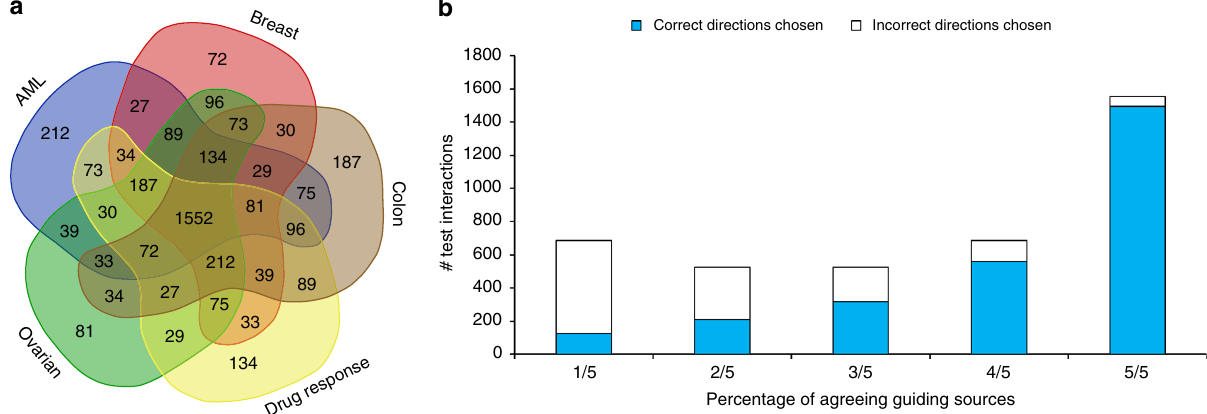
Fig. 4 Concurrence of orientations according to different sources of cause-effect information. a Depicted are the agreement of directions assigned to the test edges when independently orienting the network using (i) drug targets to differentially expressed genes, or (ii) genetic perturbations to differentially expressed genes across different cancer patients (AML, breast, colon and ovarian cancer). b The higher the agreement the higher is the orientation accuracy, which goes up to 96% when all sources